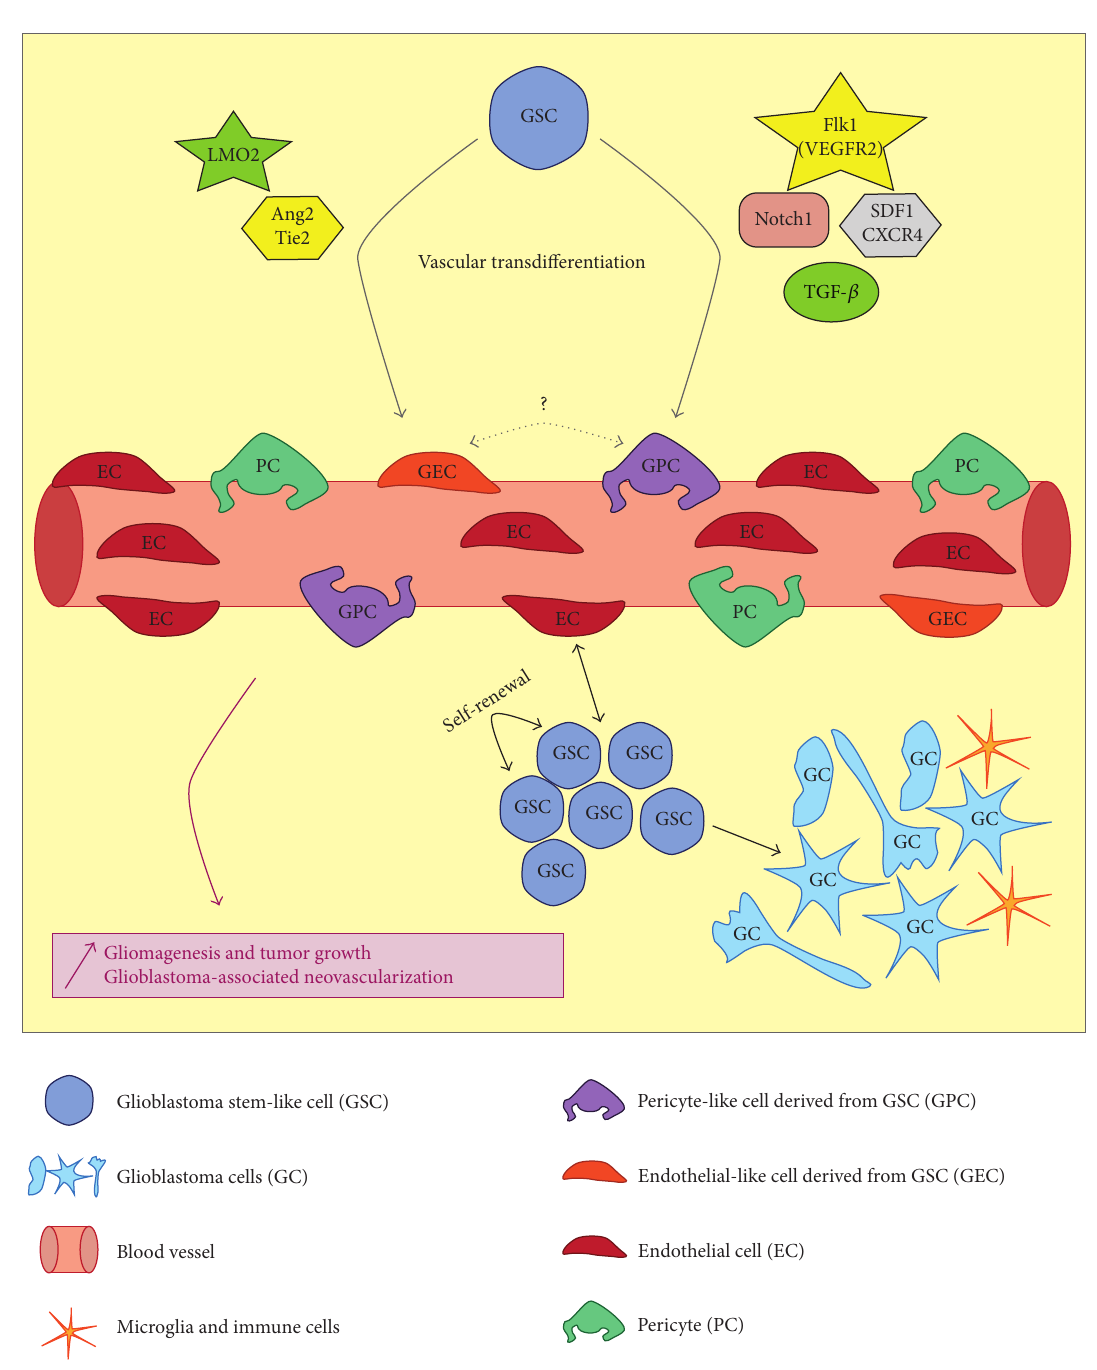
Figure 2: Schematic representation of the glioblastoma perivascular niche and the currently known mechanisms of GSC vascular transdifferentiation. GSCs closely interact with blood vessels in a complex perivascular niche. A close interaction with endothelial cells favors GSC self-renewal and maintenance; and in return GSCs promote neovascularization via several processes. GSCs also constitute the source of proliferatingglioblastoma cells which showphenotypical heterogeneity. Thetumorisalso inclosecontact with local immunecells (microglia). Vascular transdifferentiation of GSCs into endothelial-like cells is induced via transcriptional regulation of LMO2 and also activation of Tie2 receptor. Transdifferentiation in pericyte-like cells is controlled by Notch1, TGF 𝛽 , Flk-1, and SDF1-CXCR4 pathways. Consequently, these tightly controlled mechanisms ensure glioblastoma growth as well as tumor-associated